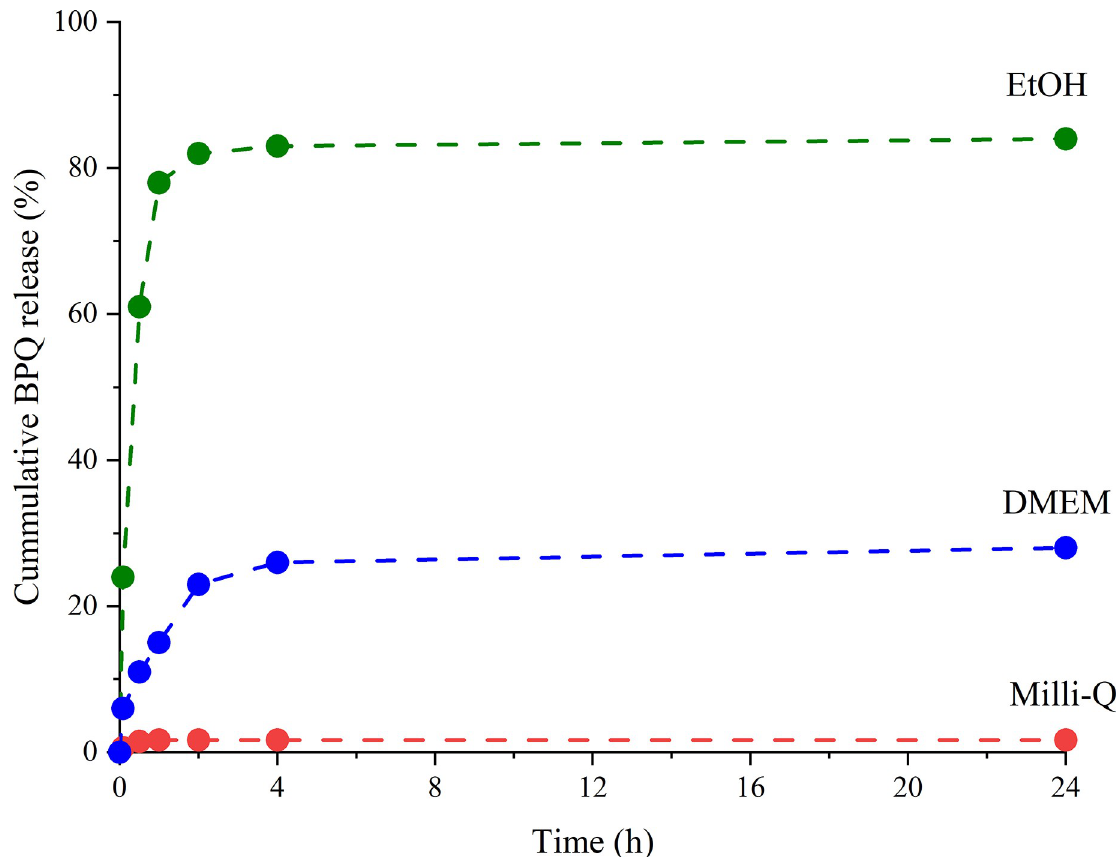
Fig 3. Release kinetics of BPQ from the freeze-dried BPQ+NP samples in different media.